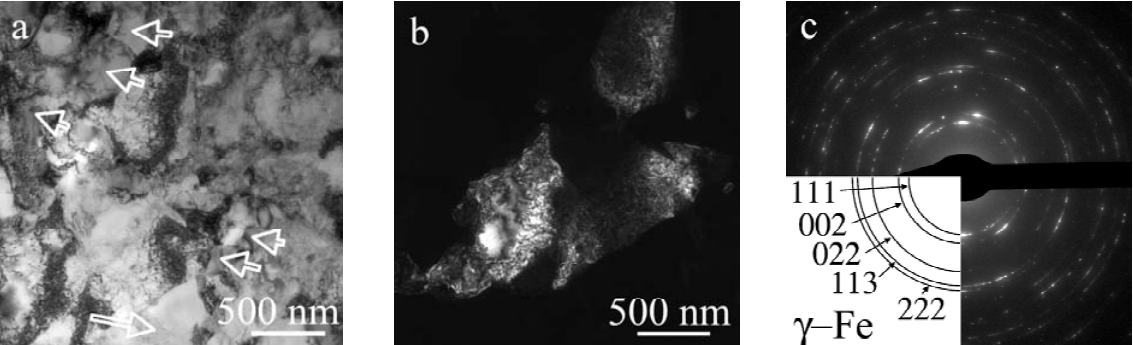
Fig. 1. TEM bright-field (a) and dark-field (b) images, and SAED pattern (c) in UFG-CrNiTi steel. Arrows on the image (a) show dislocation-free grains. SAED pattern corresponds to the image (a) and is obtained from the area of 27  m 2 .